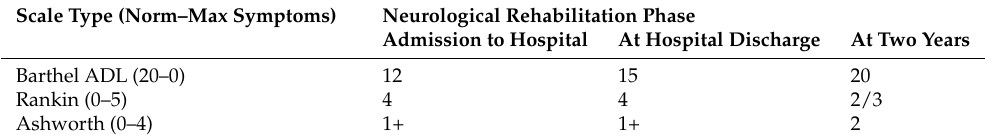
Table 4. Case study patient’s